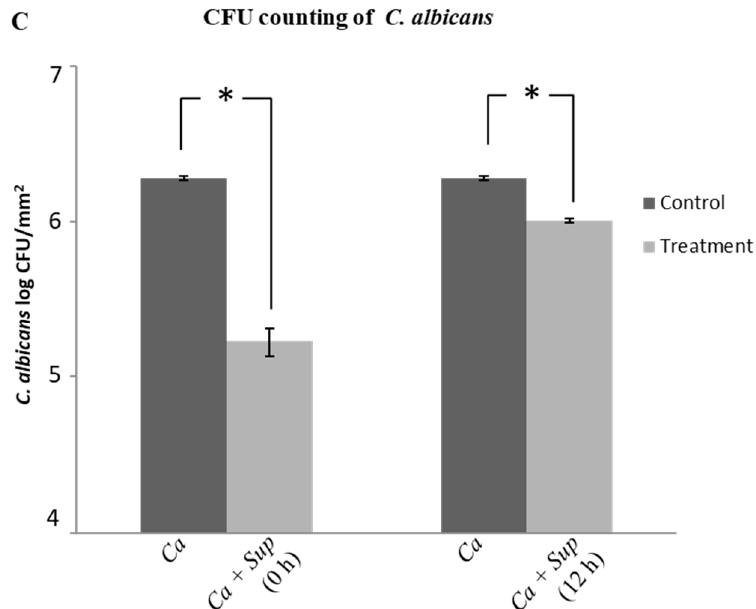
Figure 3. Lactobacillus plantarum 108 supernatant (Sup) inhibited C. albicans (Ca) biofilm formation and demonstrated therapeutic activity against preformed biofilms. ( A ) XTT reduction assay, ( B ) Crystal Violet assay, and ( C ) Colony forming unit counting (CFU) were used for the quantification of biofilms treated with the supernatant at 0 h for the preventive assay and at 12 h for the therapeutic assay. Data are presented as mean + SD and statistical significance (*) was evaluated with respect to the untreated group ( p < 0.05).